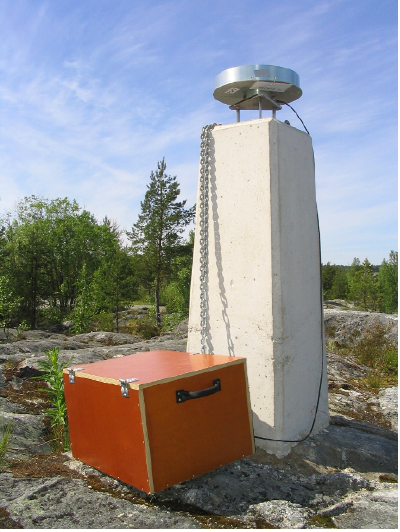
Figure 2. An example of a pillar point during a measurement cam-